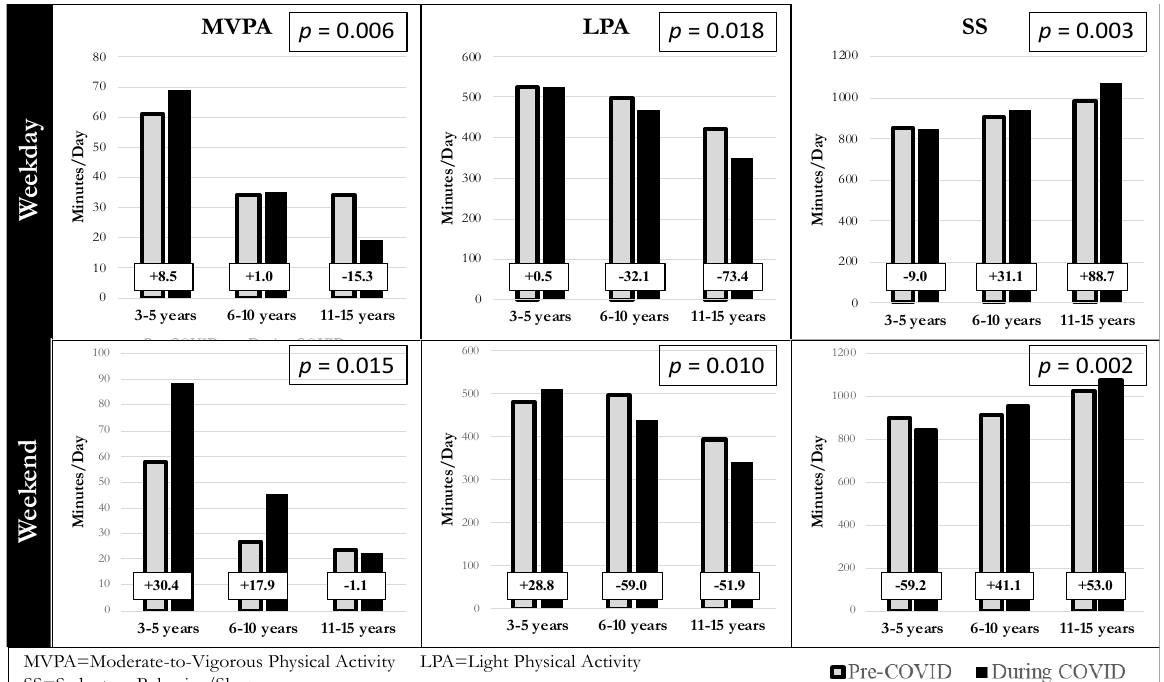
Figure 2. Raw mean change in weekday and weekend accelerometer-measured physical activity ( n = 75) from pre-pandemic (2017–2019) to early-pandemic (Spring 2020) by age group (preschool [ n = 22]; elementary [ n = 21]; middle [ n = 32]), as determined by age at pre-pandemic. p -values indicate significant age-by-time interactions from linear mixed